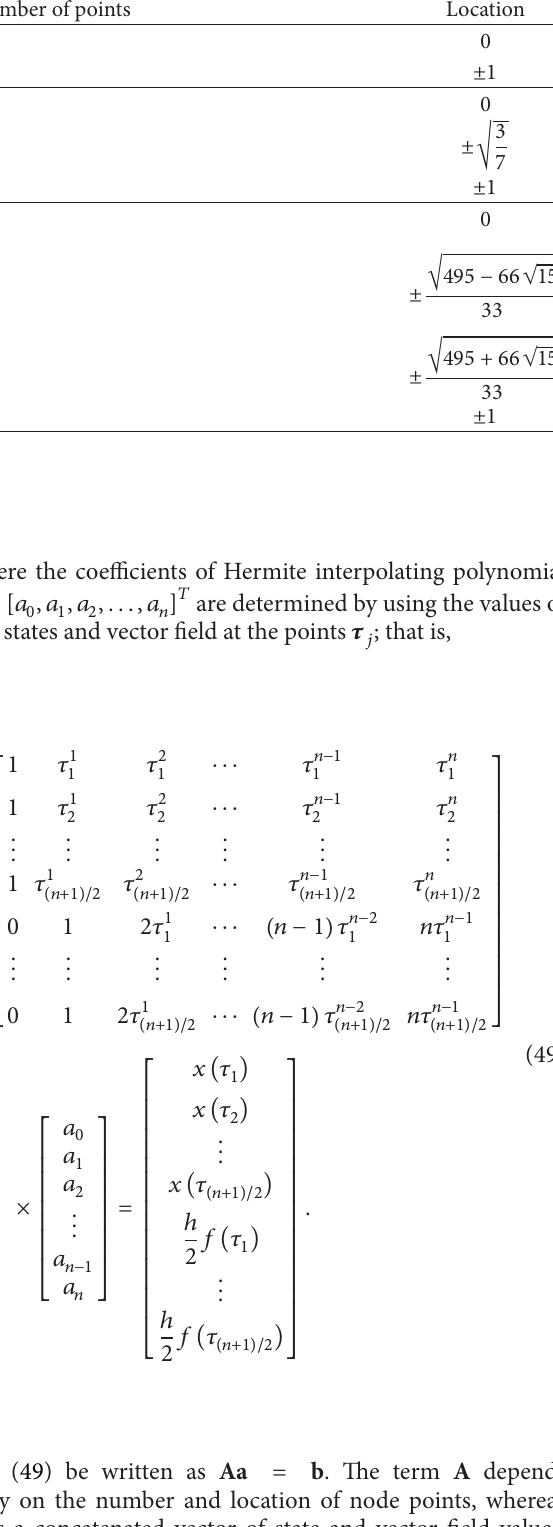
Table 1: Locations three, five, and seven Legendre-Gauss-Lobatto points.